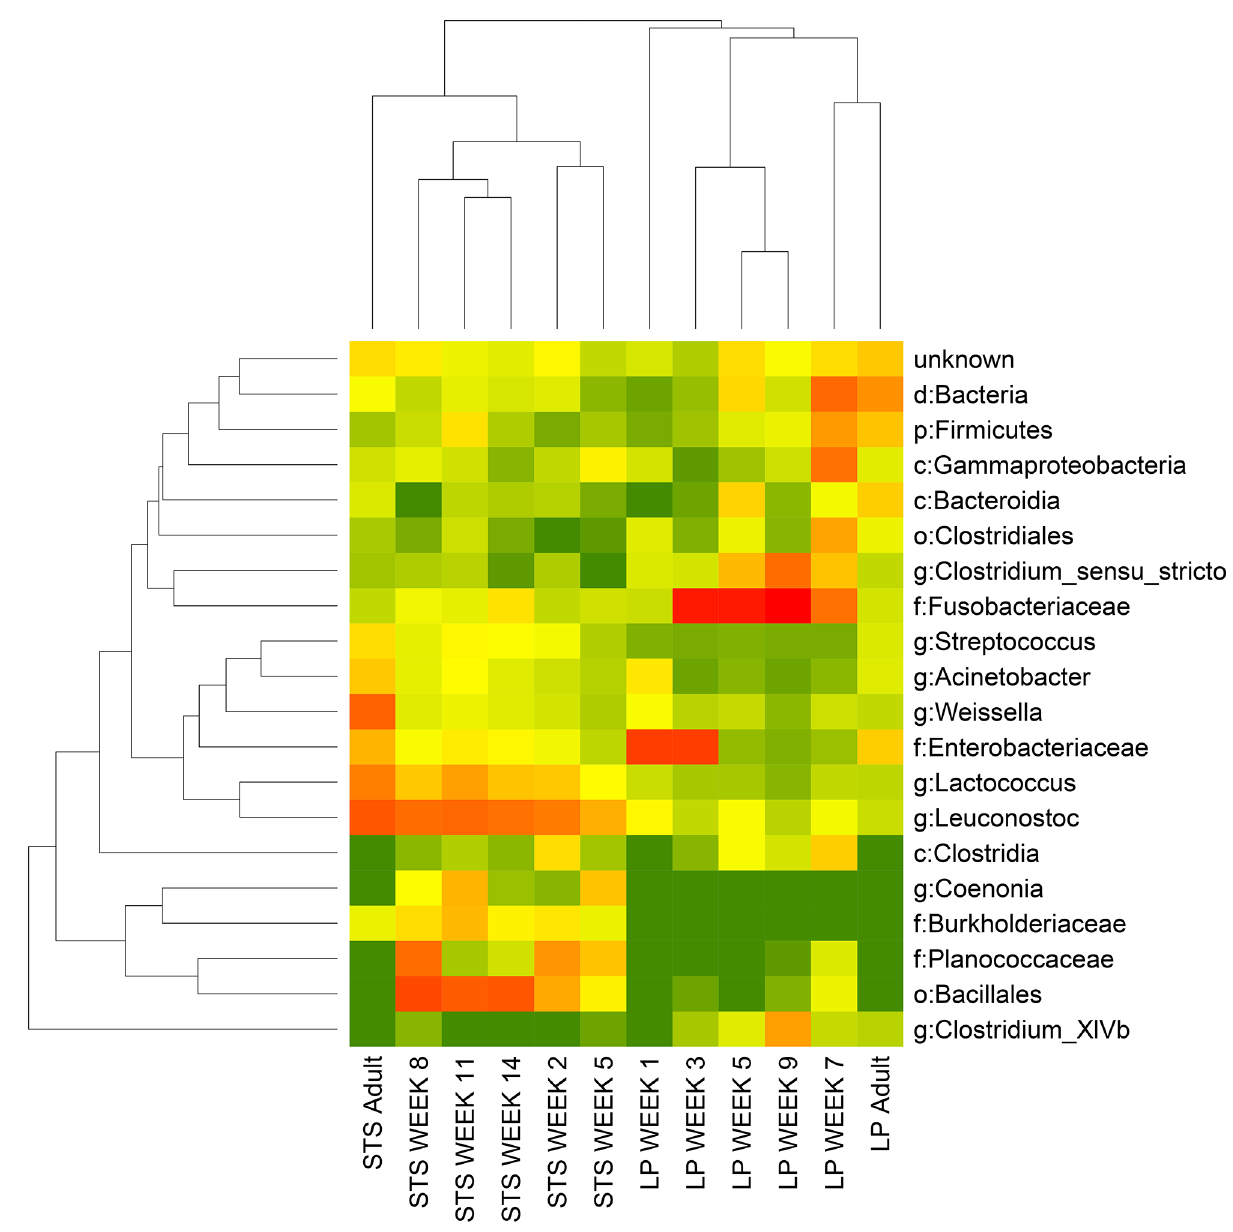
Fig 2. Heat map of 20 most abundant OTUs in STS and LP chicks and adults. Assignedtaxonomy(UPARSE, 90% confidence) is shown for each OTU.